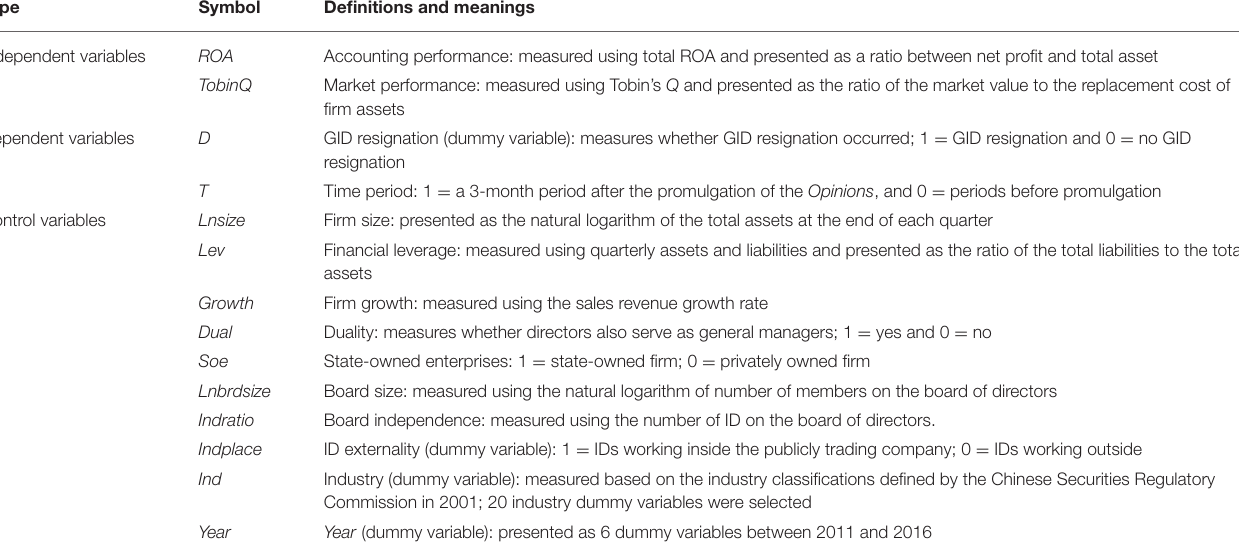
TABLE 2 | Variable definitions. Type